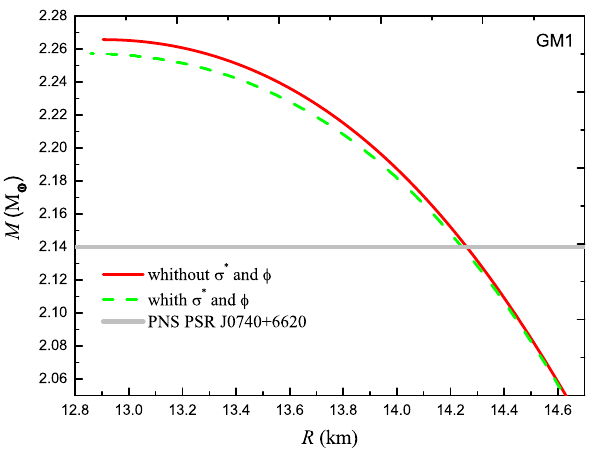
Fig. 2 Influence of hyperon interaction on the radius of PNS PSR J0740+6620. Mesons σ ∗ and φ describe the interaction between hyper- ons. The temperature of the PNS is chosen as T = 20 MeV and nucleon coupling constant GM1 is